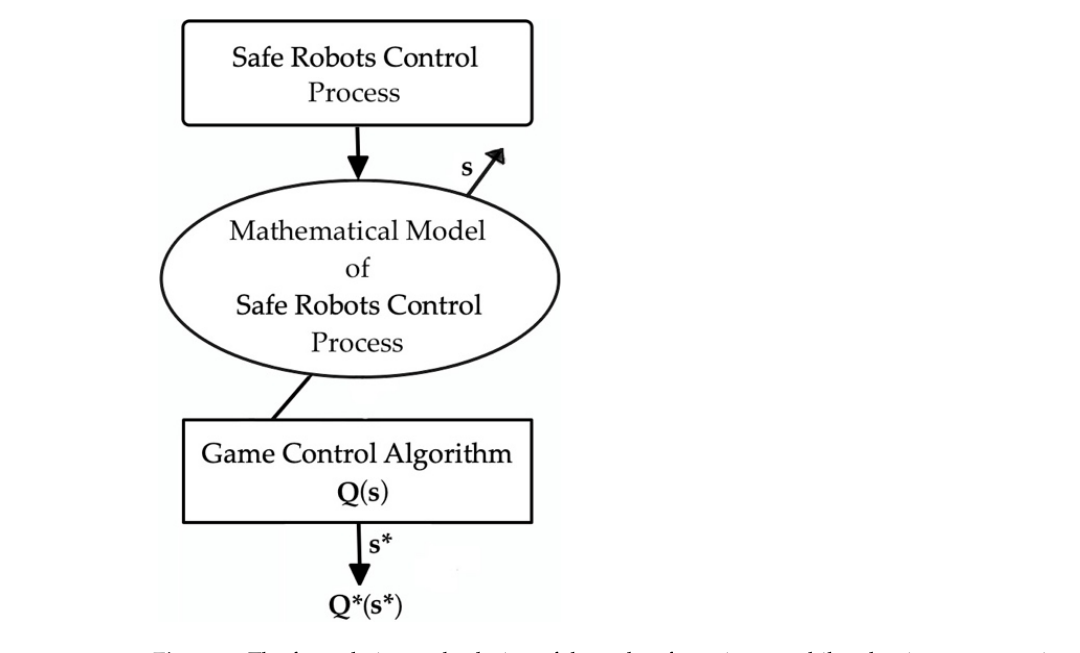
Figure 1. The formulation and solution of the tasks of steering a mobile robot in a game environment: s—permissible strategies; s * —optimal strategies; Q(s)—quality control index; Q * (s * )—optimal value of quality control index.